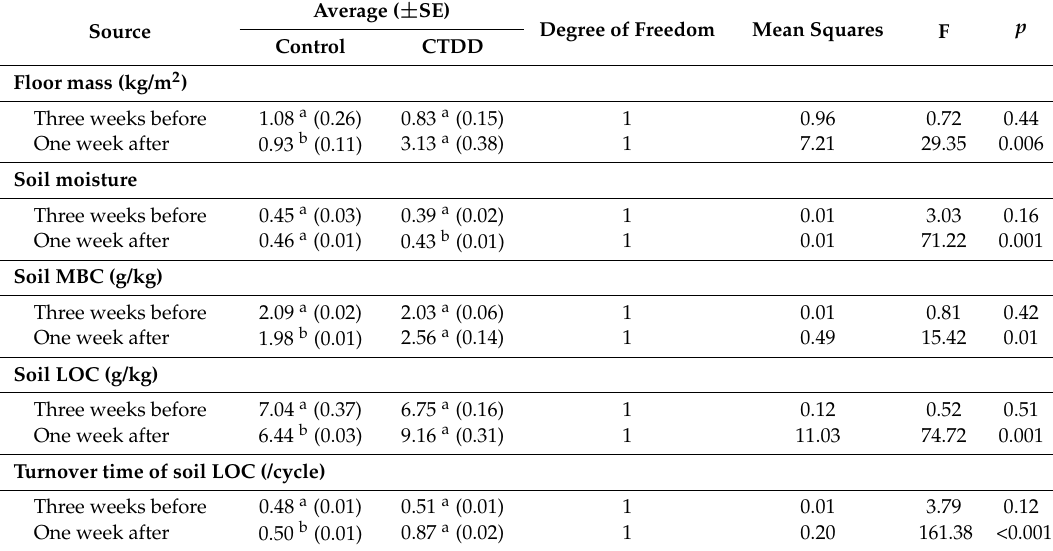
Table 1. One-way ANOVA statistical analyses of floor mass, soil moisture, soil MBC, soil LOC, and turnover rate of soil LOC three weeks before and one week after the CTDD treatment in the control and treatment plots in the tabonuco forest, Puerto Rico. Dependent variables are floor mass, soil moisture, soil MBC, soil LOC, and turnover rate of soil LOC. Independent variables are the control and CTDD treatment. The same superscripts indicate no significant difference between the control and CTDD plots at α = 0.05. Same superscripts (a and b) indicate no significant difference between the control and CTDD